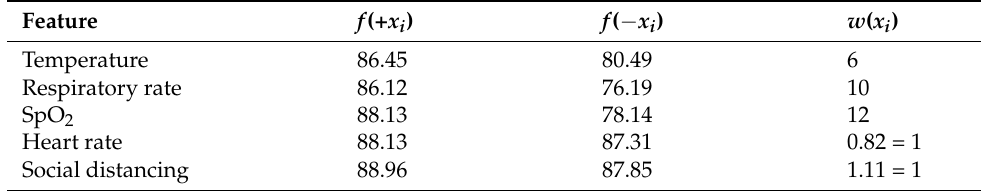
Table 4. Weight assignment using